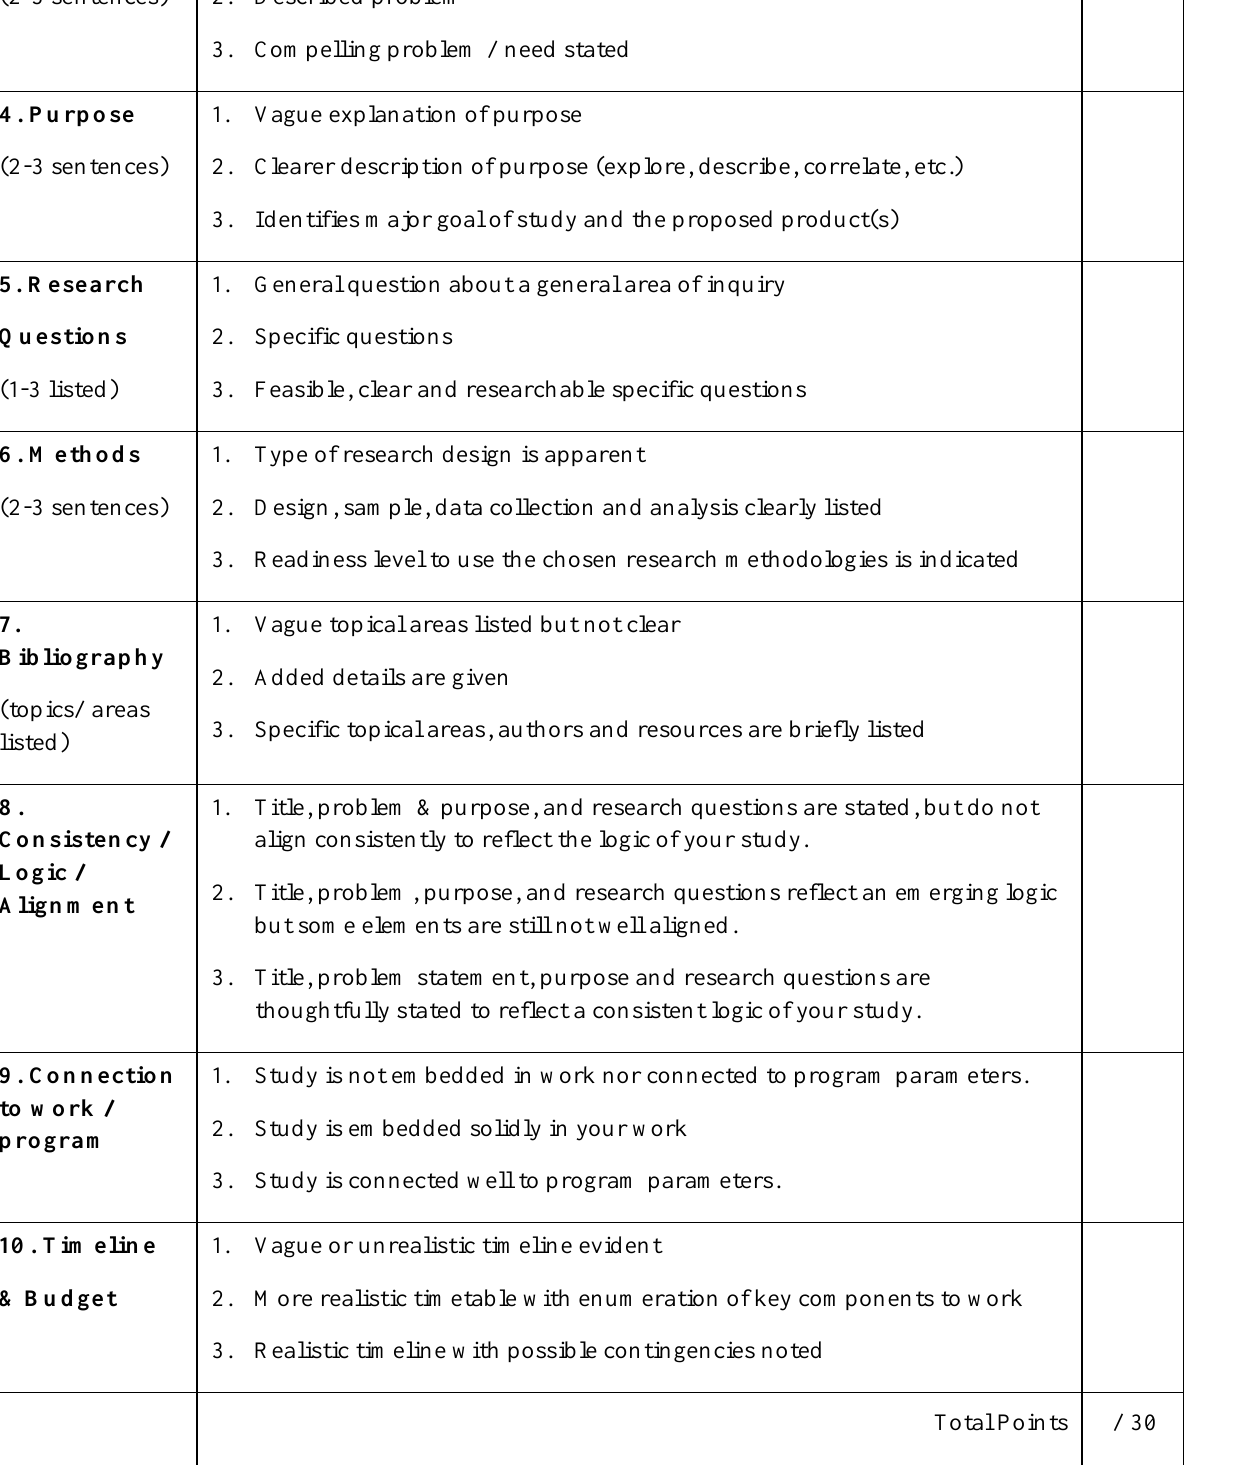
Figure 2 . Dissertation topic